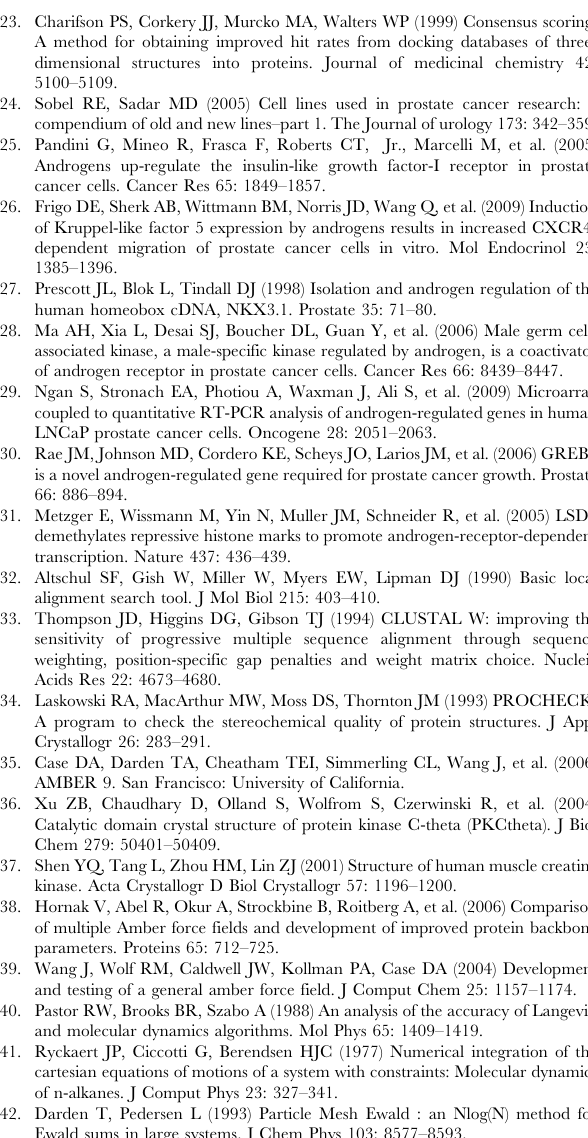
Figure S7 Effects of lestaurtinib and Ro318220 on the phosphorylation of H3T11 in LNCaP cells after 18 h. (TIFF) Table S1 Scoring values obtained for 63 docked Biomol compoundsand sevenmore ofthetested